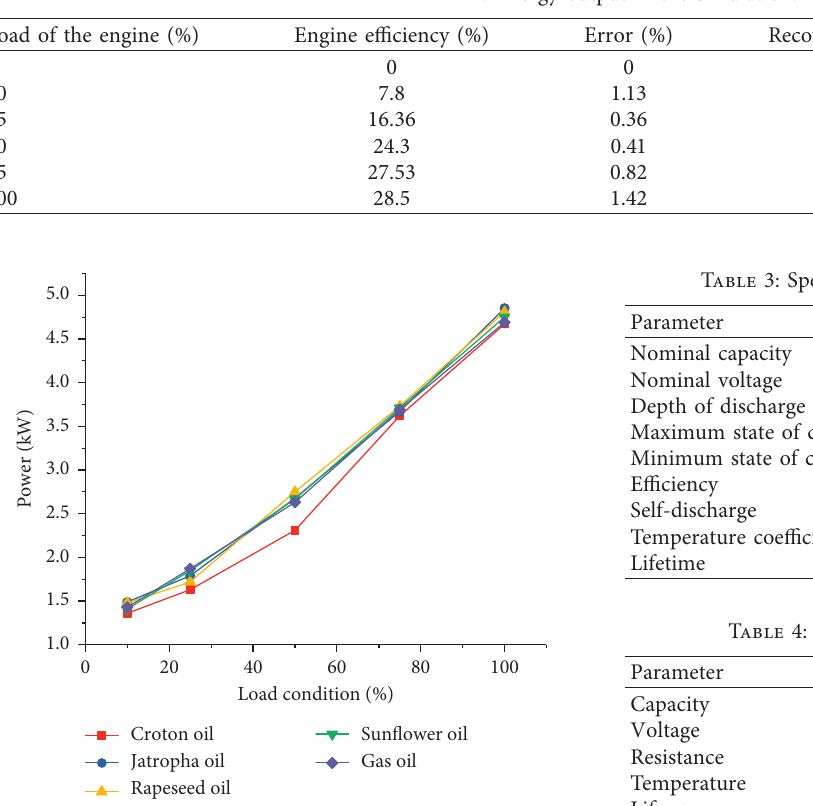
Table 2: Energy output in the simulation.